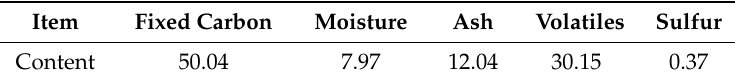
Table 3. Industrial analysis results of bituminous coal (mass/%).